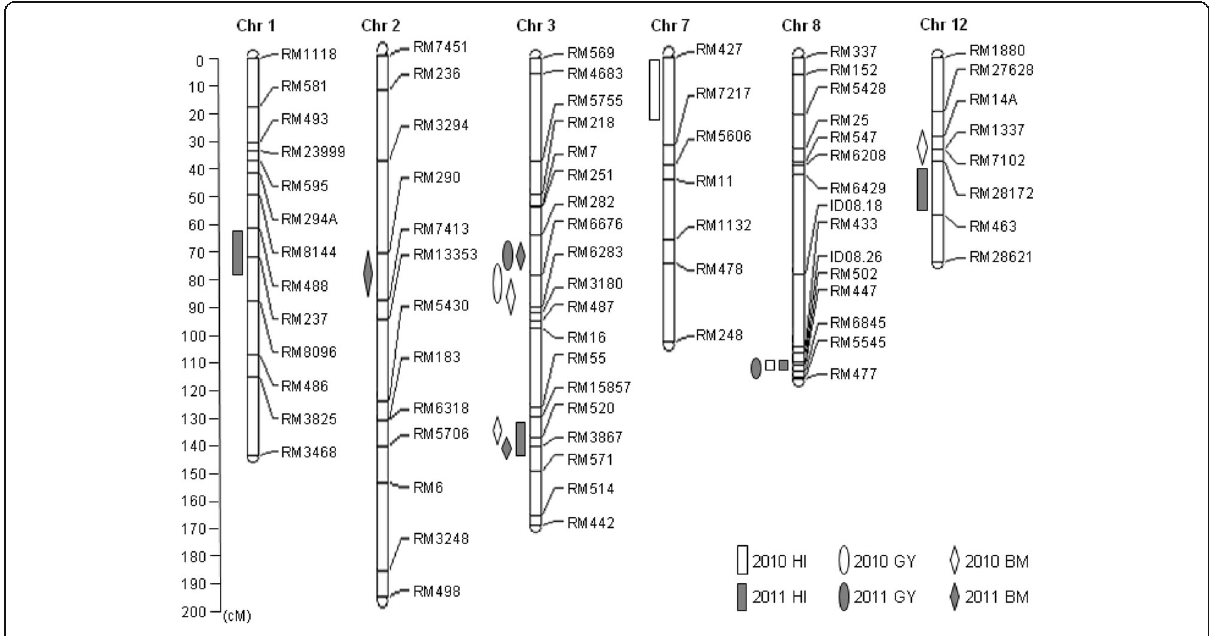
Fig. 2 Chromosomal locations of QTLs for harvest index, grain yield and biomass identified in two years (2010 and 2011)